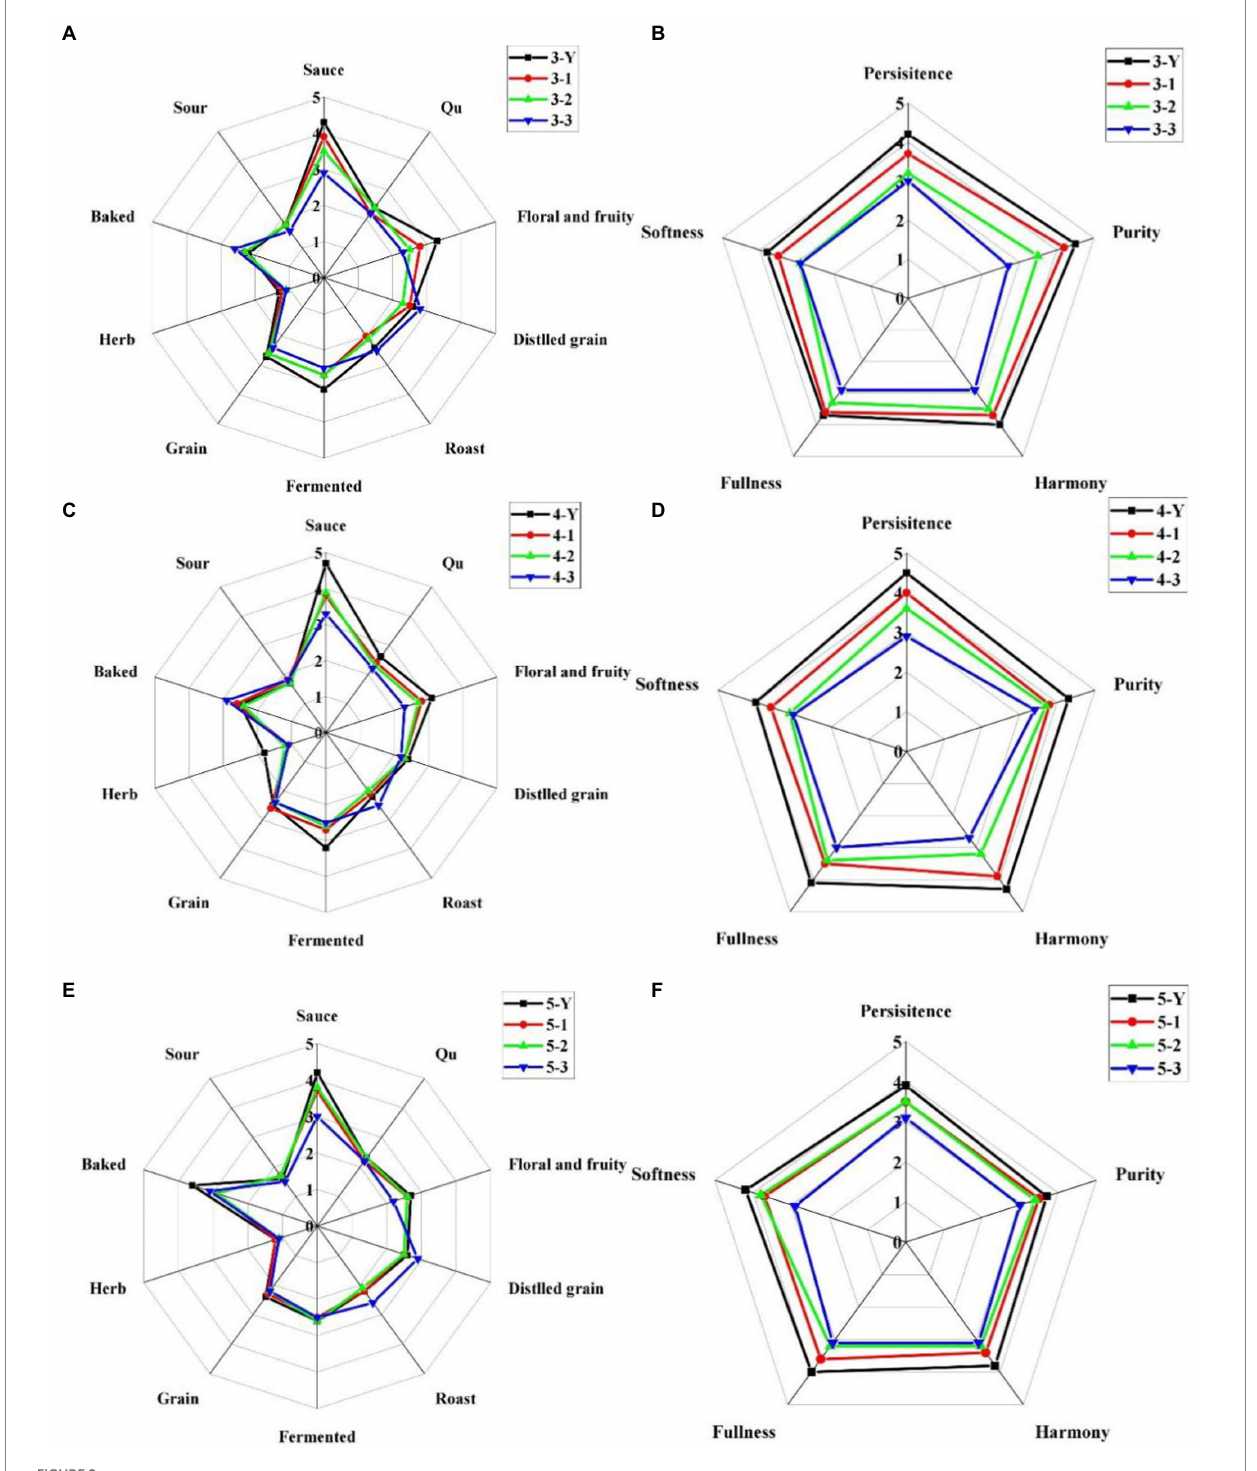
FIGURE 2 Sensory evaluation of different quality grades of base liquor of three rounds of fermentation, (A,C,E) are the aroma profiles of 3rd, 4th, and 5th round of fermentation, respectively; (B,D,F) is the taste profiles of 3rd, 4th and 5th round of fermentation,